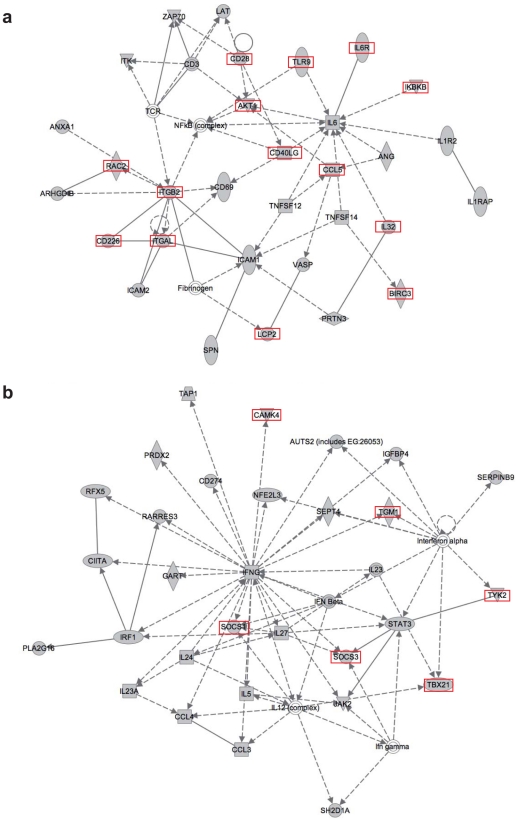
Genes targeted by MLV integration clusters are functionally linked in gene networks.Networks originated by Ingenuity® analysis of 31 (a) and 30 (b) eligible T cell pre-infusion cluster targets. The most relevant networks, having a score of 21 (p<10−14 for all top functions associated to the network a) and 19 (network b p<10−8) are indicated. Red boxes indicate the 14 (a) and 6 (b) Focus Genes in common with the post-infusion dataset.